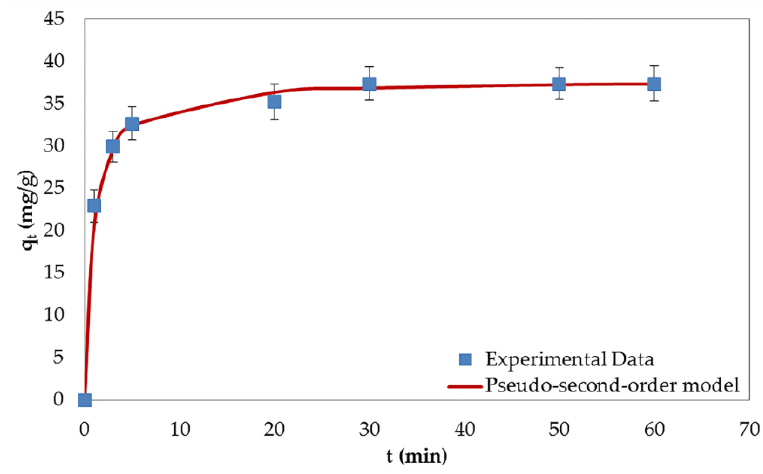
Figure 6. Adsorption kinetics of BPA on GO at the initial BPA concentration of 60 mg/L.